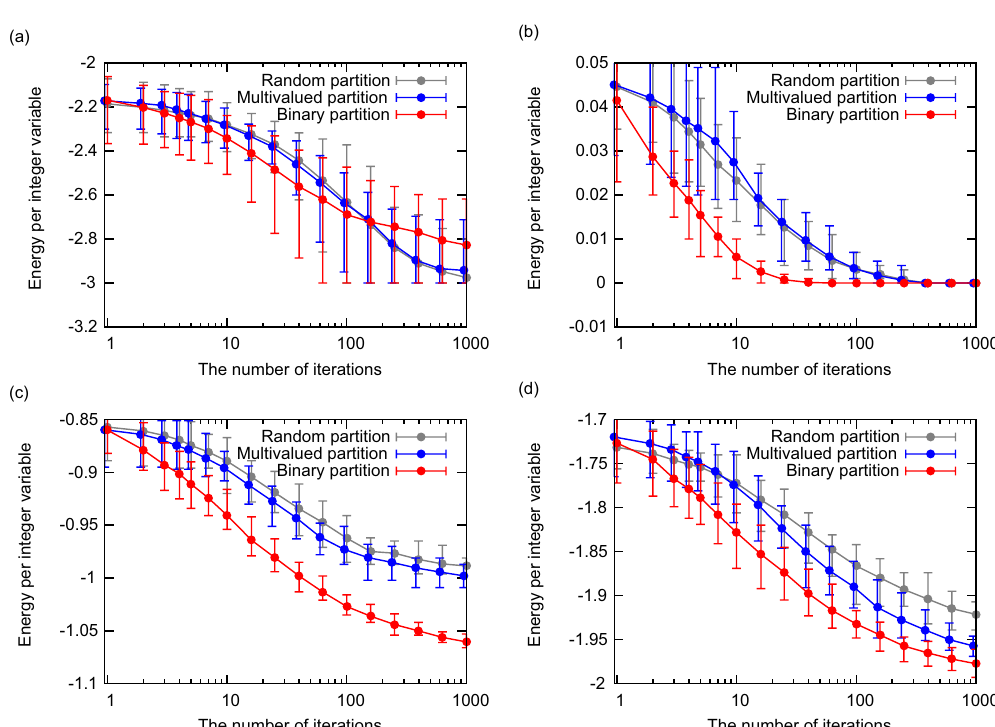
Figure 5. Energies obtained using the three partitioning methods. The average, maximum, and minimum energies for 16 trials are plotted. ( a ) Ferromagnetic Potts model. ( b ) Anti-ferromagnetic Potts model. ( c ) Potts glass model. ( d ) Potts gauge glass